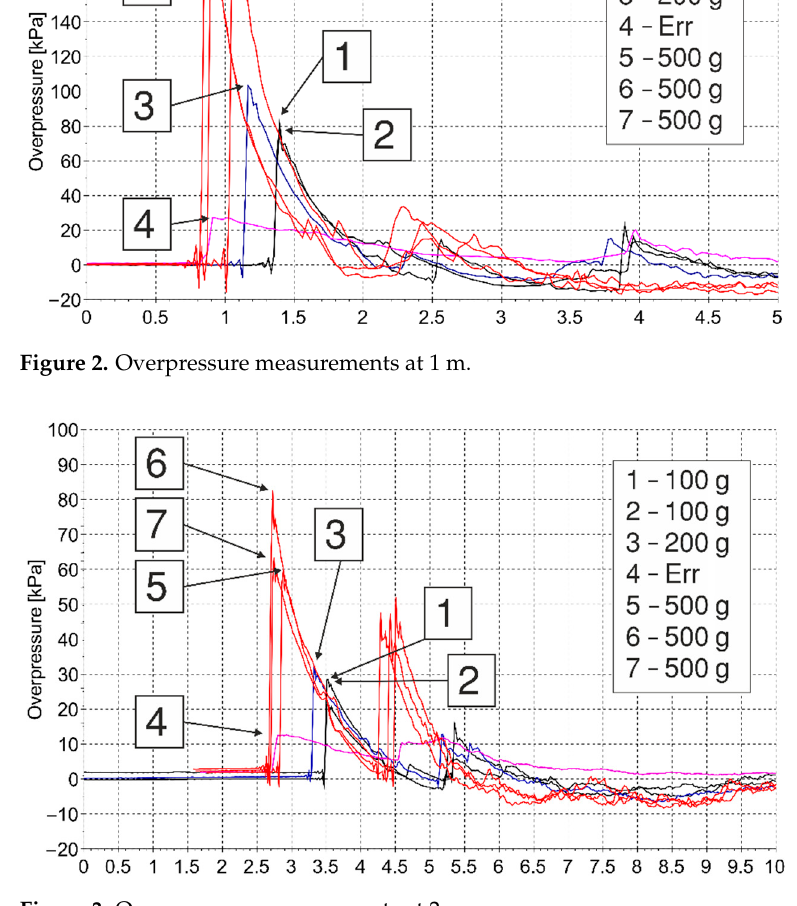
Figure 3. Overpressure measurements at 2 m.